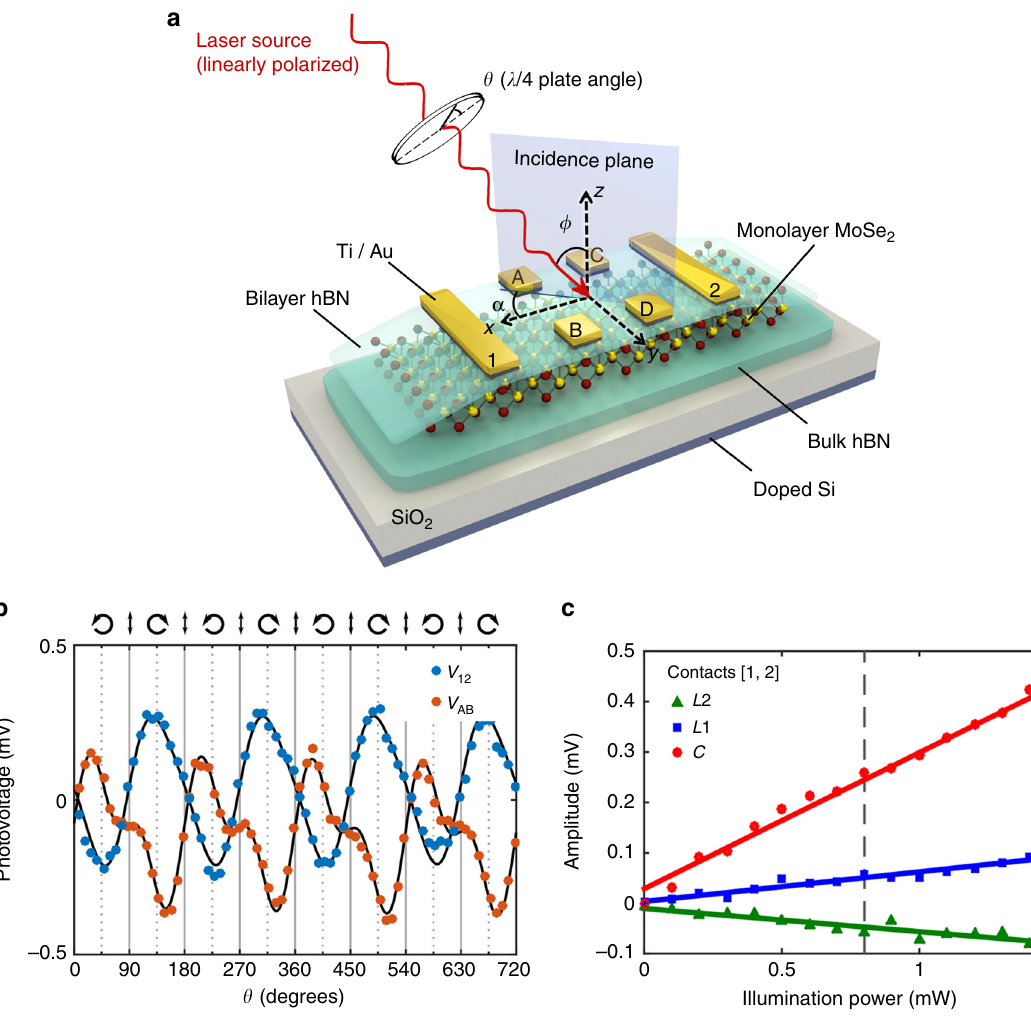
Fig. 1 Experiment geometry and helicity-dependent response. a Schematic experimental setup. The helicity of the laser excitation is controlled by rotating the quarter-waveplate angle, θ . b Helicity-dependent photovoltage of the contacts [1, 2] (blue) and [A, B] (orange) as a function of the quarter-waveplate angle θ for λ = 785 nm, ϕ = 20°, V ds = 0, V gate = 0, and α = 45°. The black lines are fi ts to the phenomenological equation (1). c Power dependence of C , L 1, and L 2 (extracted from fi ts to Eq. (1)). The solid lines are linear fi ts to the experimental data. The vertical dashed line indicates the power used during the experiments, 0.8